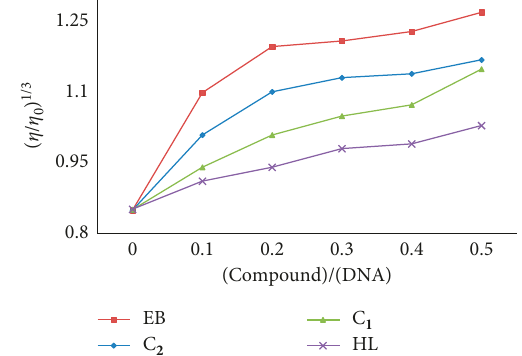
Figure 7: Effect on relative viscosity ( influence of increasing amount of compounds at 26 5mM Tris-HCl buffer (pH